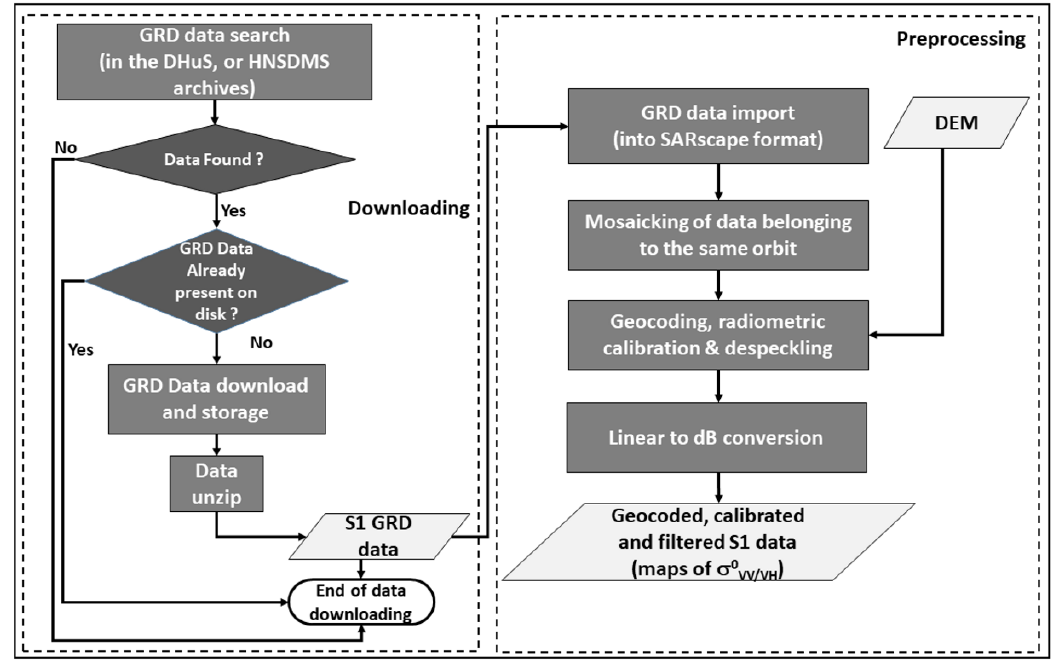
Figure 4. Block diagram of the script for S1 data downloading and preprocessing implemented in AUTOWADE.